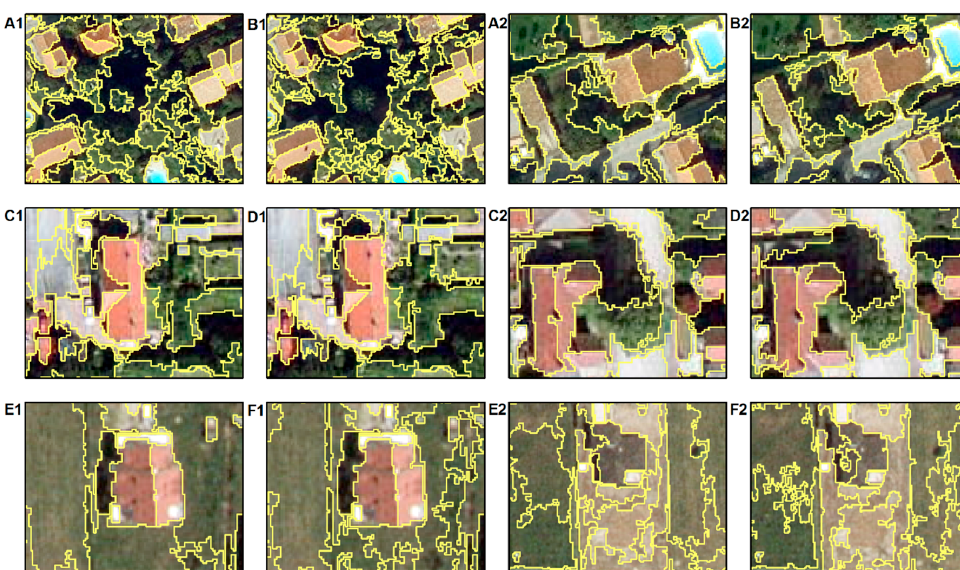
Figure 9. Subsets of segmentations in Figure 8, where the first and third columns illustrate the MRS results and the other columns the Local